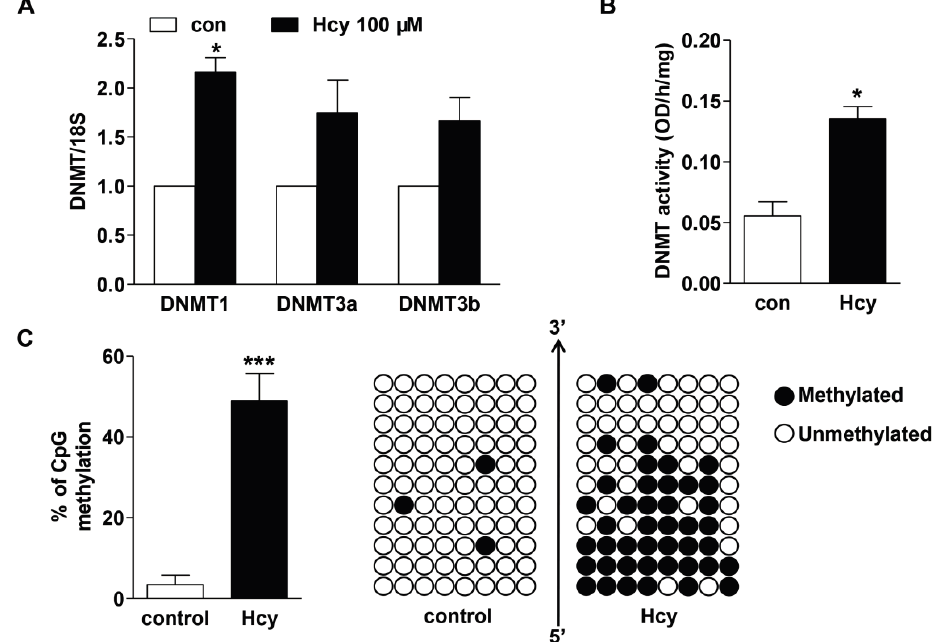
Figure 4. Hcy enhanced DNMT expression and activity in macrophages, accompanied with DNA hypermethylation in cse gene promoter. ( A , B ) One hundred micromoles Hcy treatment for 6 h enhanced DNMTs mRNA expression ( A ) and activity ( B ) in raw264.7 cells. n = 3; ( C ) BSP sequencing revealed DNA hypermethylation of mouse cse promoter that contains 11 CpG sites in Hcy-treated macrophages. Each column indicated the clones from Control ( left ) and Hcy (100 µM, right )-treated cells. The methylated CpG sites were labeled in black circles and unmethylated CpG sites were labeled in white circles. * p < 0.05, *** p < 0.001 compared to its corresponding